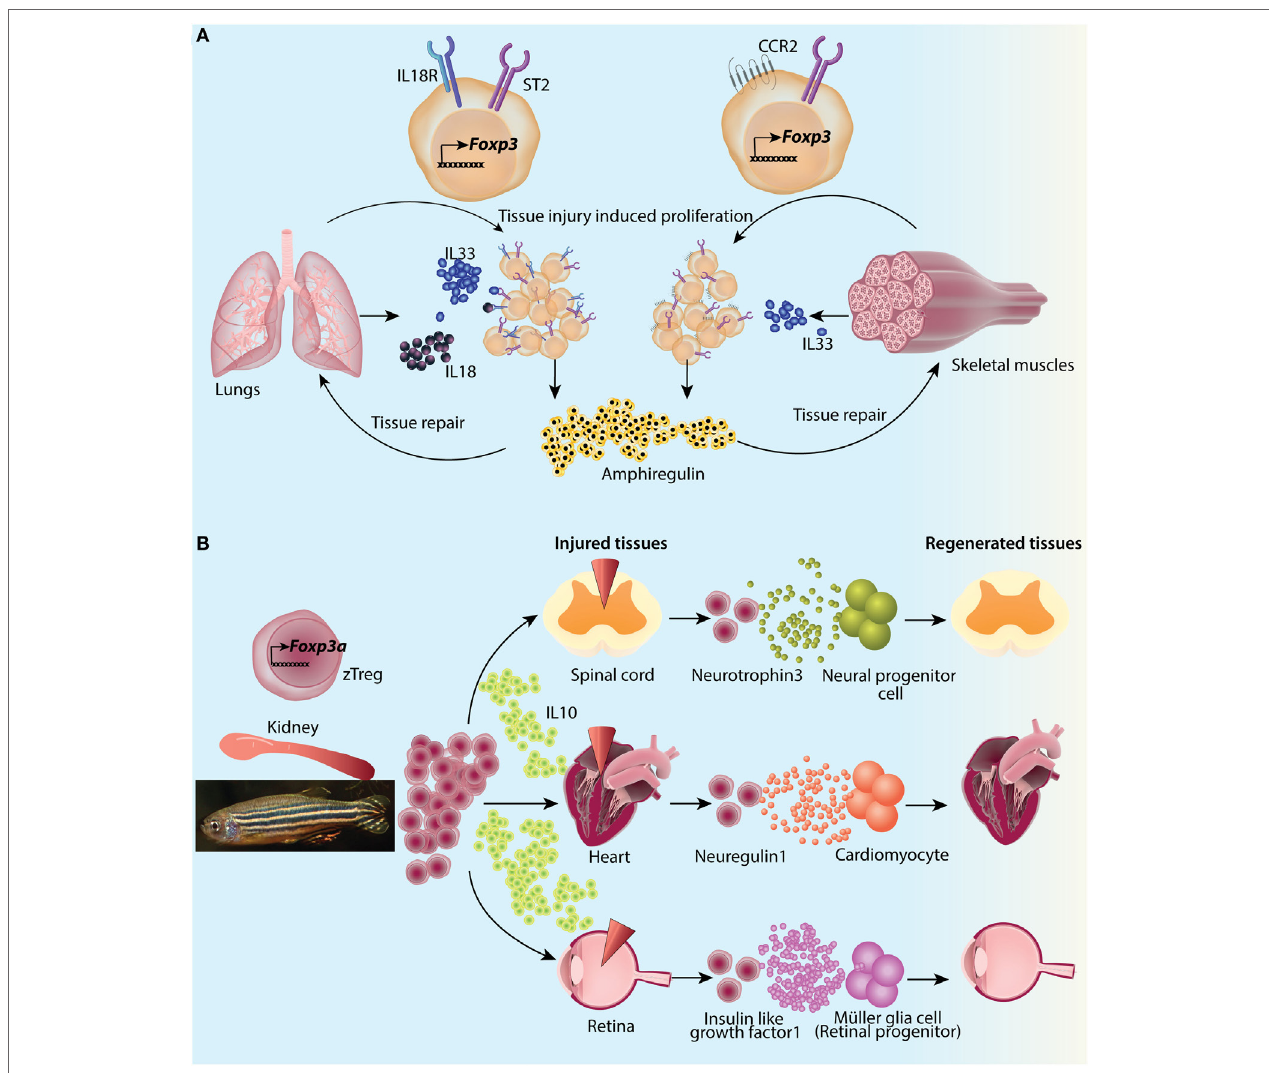
FiGURe 8 | Emerging evidences highlight a compulsory requirement of regulatory T-cells (Tregs) in tissue regeneration and repair. (A) Both lungs and muscles contain population of Tregs which proliferate vigorously upon tissue injury. Lung reparative Tregs respond to both inflammatory IL18 and alarmin IL33 and produce amphiregulin in a TCR-independent manner. Muscle Tregs respond to IL33 produced upon muscle damage and produce amphiregulin for subsequent repair. (B) In zebrafish, mammalian Foxp3 ortholog Foxp3a expressing Tregs (zTregs) are primarily present in kidney. However, upon tissue injury, they soon accumulate at the site of the injury. Apart from anti-inflammatory IL10 production, zTregs co-localize with organ progenitor cells and provide tissue-specific growth factors to progenitors like neurotrophin3 for neural progenitors in spinal cord, neuregulin1 for cardiomyocytes in heart, and insulin-like growth factor1 to Müller glial cells in